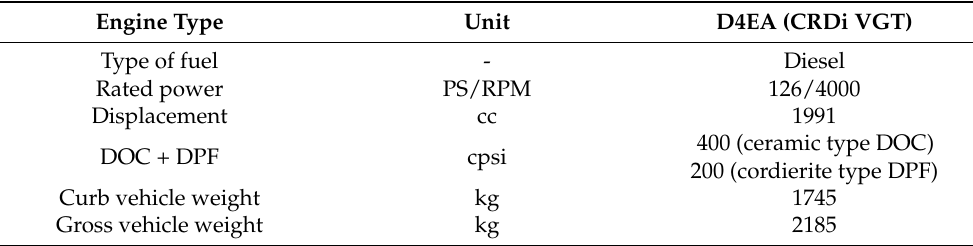
Table 1. Engine specification of the vehicle used in this